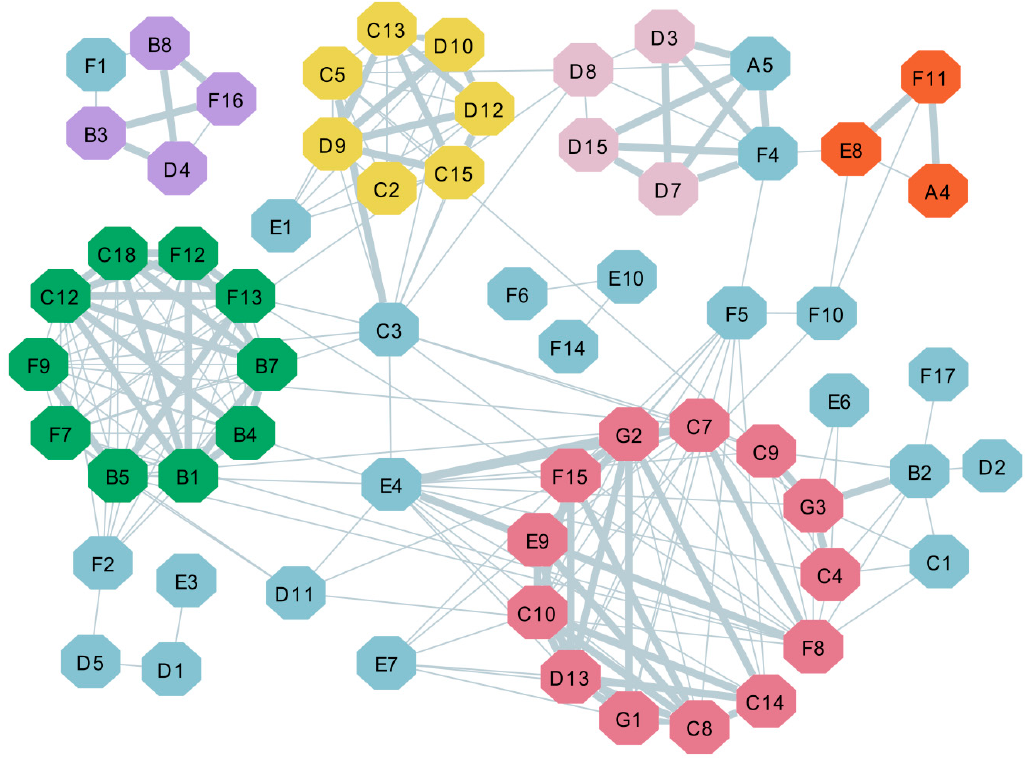
Figure 7. Pearson correlation visualization network for every two compounds (OAV > 1) based on GC-MS data. The nodes represent different compounds. The edge width was proportional to the r values. Grey edges represent positive correlations between two compounds. This view shows all interactions with high and medium Pearson correlation coefficients (|r| > 0.6, p < 0.05).